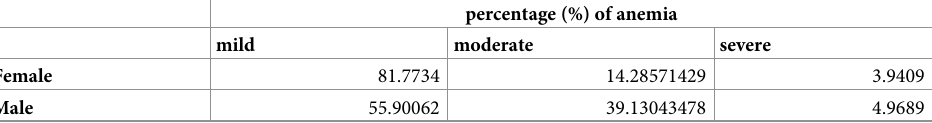
Table 4. Gender wise prevalence of Anemia in the study population.